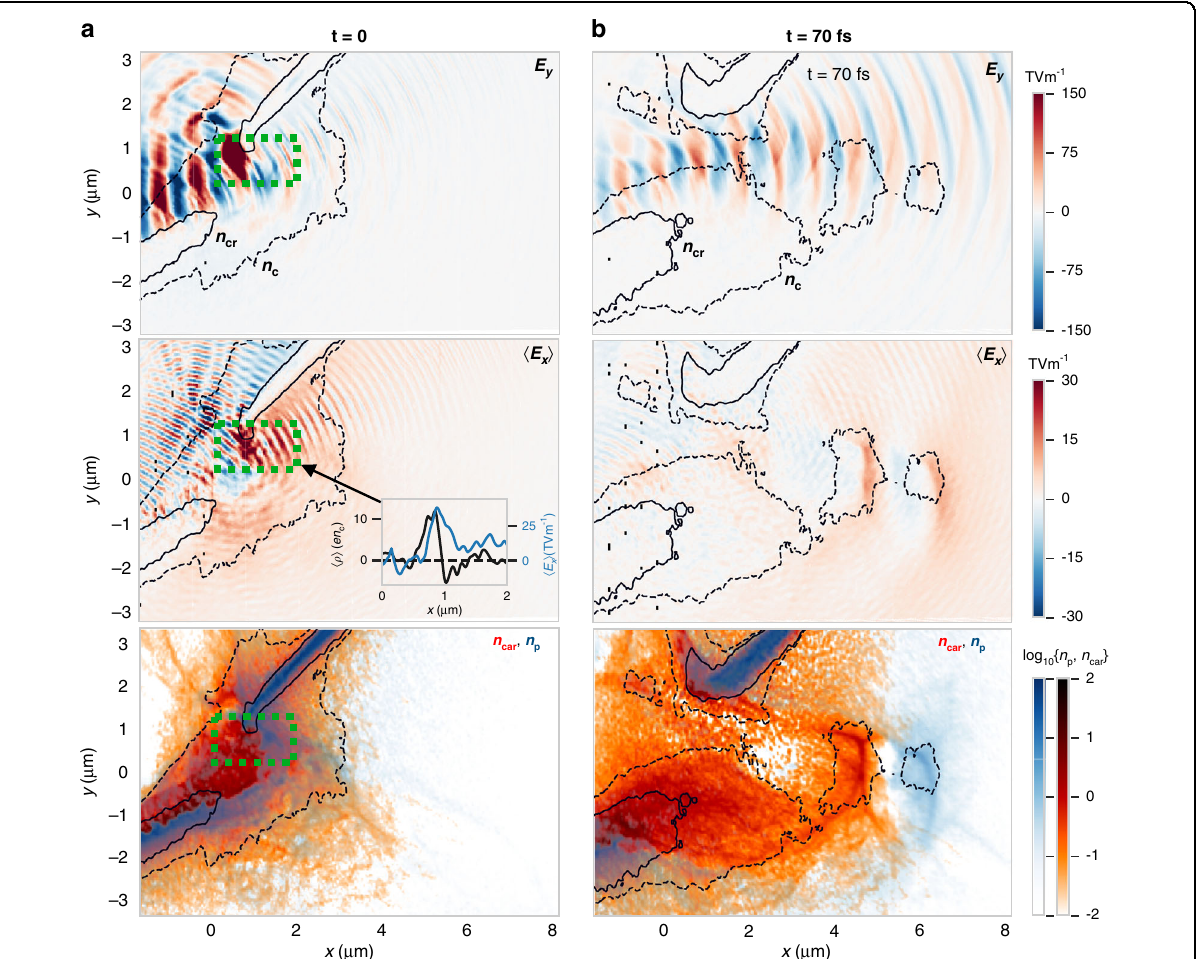
Fig. 4 Dynamics of laser-plasma interaction at optimum target thickness. a 2D slice ( z = 0) of E y , 〈 E x 〉 and carbon/proton density ( n car , n p normalised to n c ) for a 250nm target at t = 0, when the peak of the pulse arrives. The solid (dashed) contours give the relativistic (classical) critical electron density. The region of strong electron expulsion is highlighted by the green box. The inset shows the cycle-averaged space charge density 〈 ρ 〉 and 〈 E x 〉 for a lineout through the centre of the green box, averaging over Δ y = 400nm. b The same 2D slices shown at t = 70fs, at the end of the main pulse interaction, showing the acceleration of the separated ion species in the thermal sheath fi